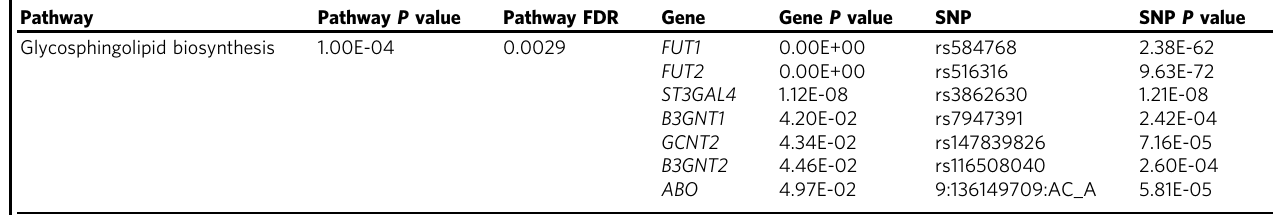
Table 6 MAGENTA pathway analysis on mumps GWAS Pathway Glycosphingolipid biosynthesis